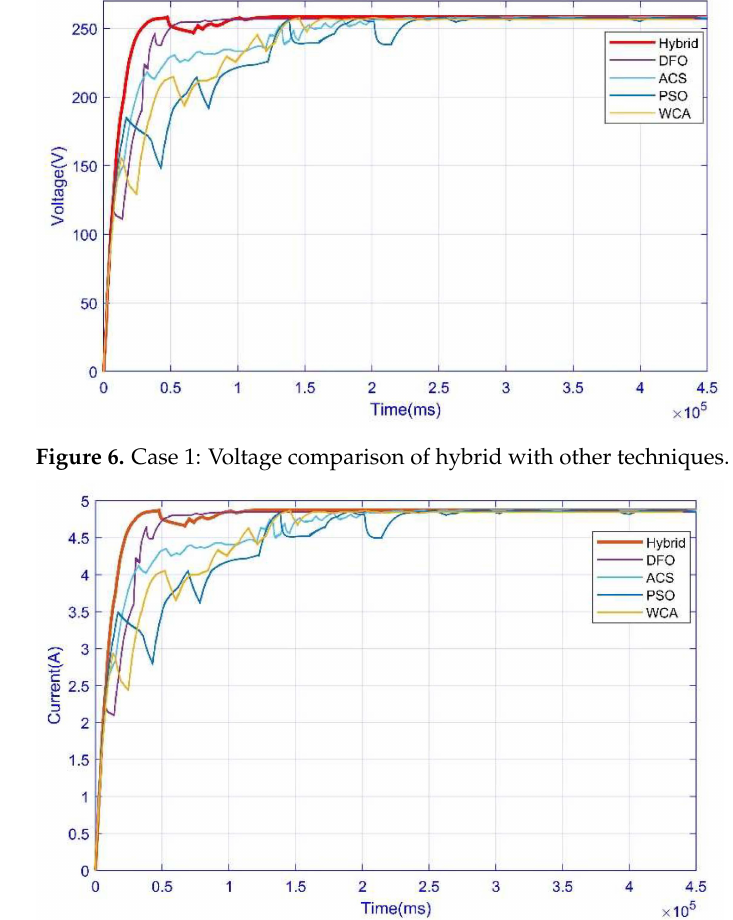
Figure 7. Case 1: Current comparison of hybrid with other